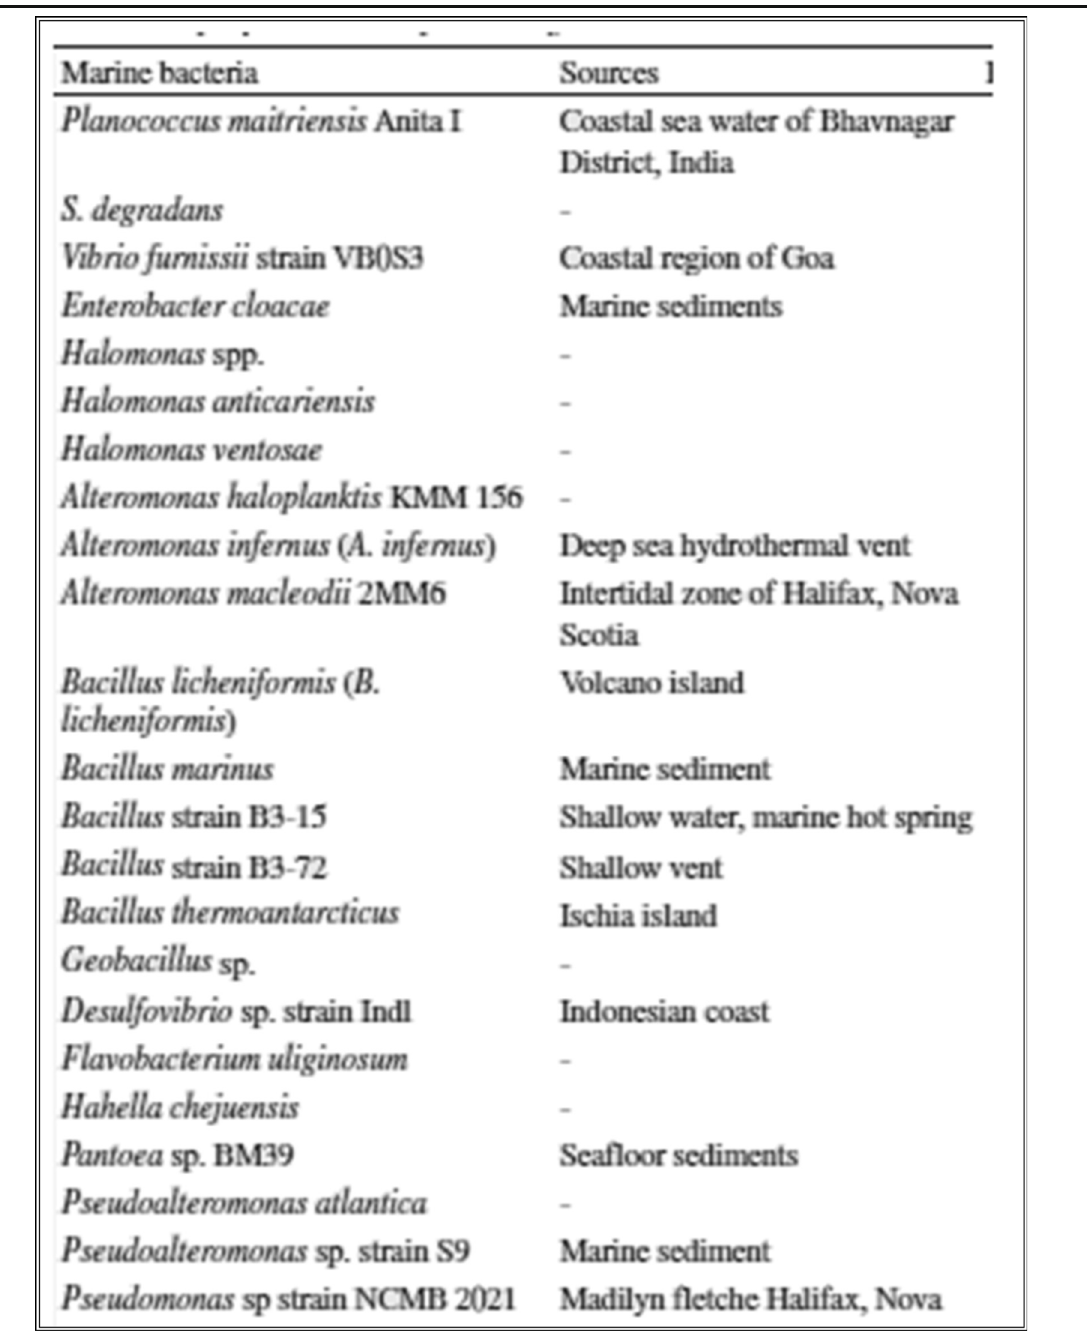
Table 2 Some exopolysaccharides producing marine